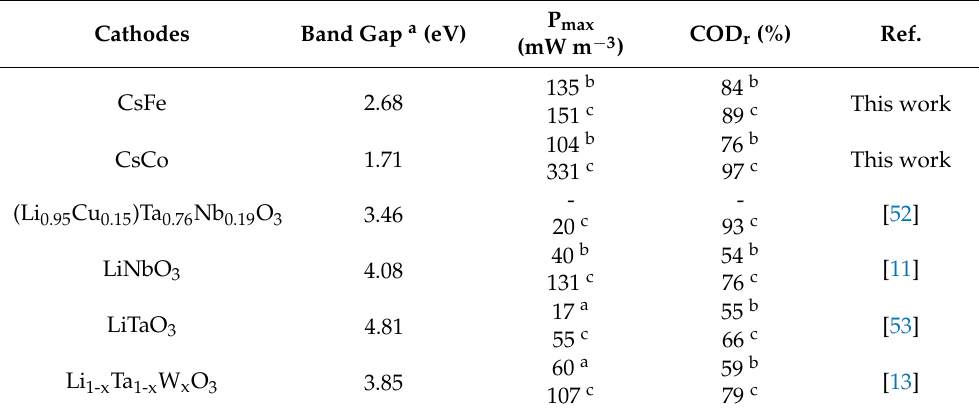
Table 4. Comparison of recent results in terms of bandgap, power output, and COD reduction rate of various MFC representative